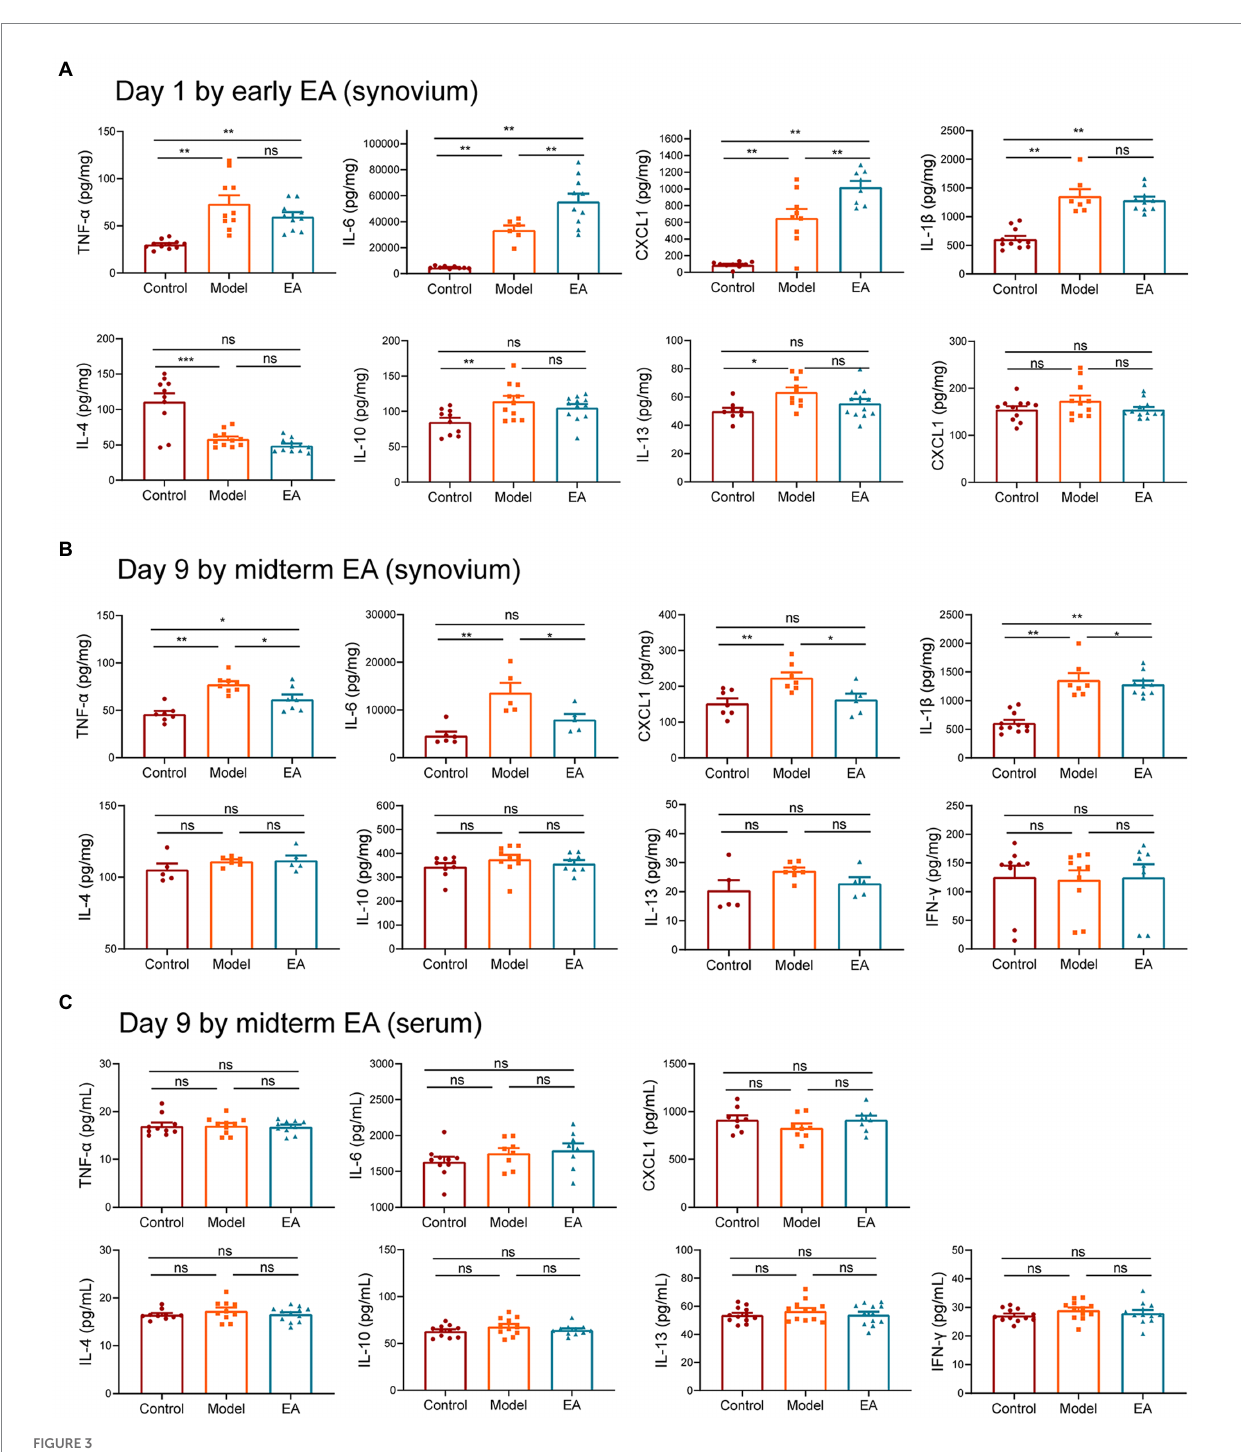
FIGURE 3 Midterm EA suppressed the levels of proinflammatory cytokines CXCL1, IL-6, TNF- α , and IL-1 β in the synovium of MIA-induced KOA rats. (A) The levels of proinflammatory cytokine CXCL1, IL-6, TNF- α , and IL-1 β were increased on day 1 after MIA injection; however, the levels of proinflammatory cytokine CXCL1, IL-6 in the early EA group were increased more than those in the model group, whereas no significant difference was observed in the levels of proinflammatory cytokine TNF- α and IL-1 β between the model group and the early EA group on day 1 after MIA injection ( n = 12, * p < 0.05, ** p < 0.01, *** p < 0.001). (B) The levels of proinflammatory cytokine CXCL1, IL-6, TNF- α , and IL-1 β were increased on day 9 after MIA injection in the model group, whereas they were decreased in the midterm EA group ( n = 9, * p < 0.05, ** p < 0.01, *** p < 0.001). No statistical difference was observed in the levels of cytokine IFN- γ , IL-4, IL-10, and IL-13 in the synovium among the three groups. (C) No statistical difference was observed in the levels of all cytokines in the serum among the three groups ( n = 9, * p < 0.05, ** p < 0.01, *** p <